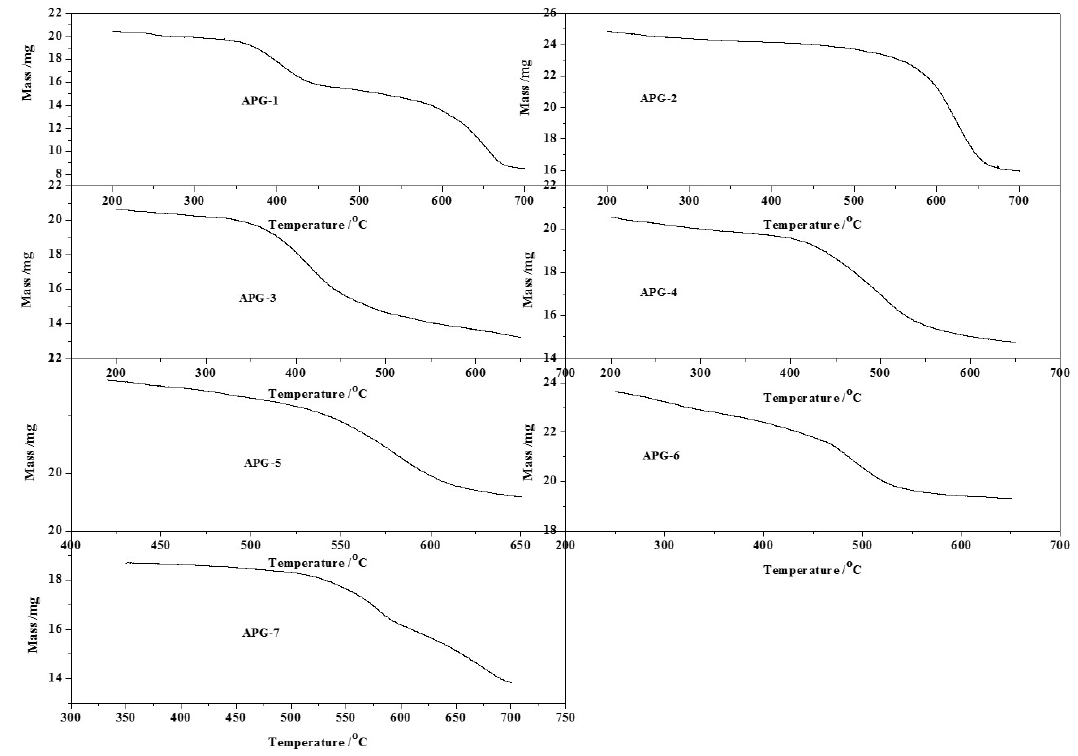
Figure 7. Reduction performances of spent sulfur transfer catalysts with different metals.